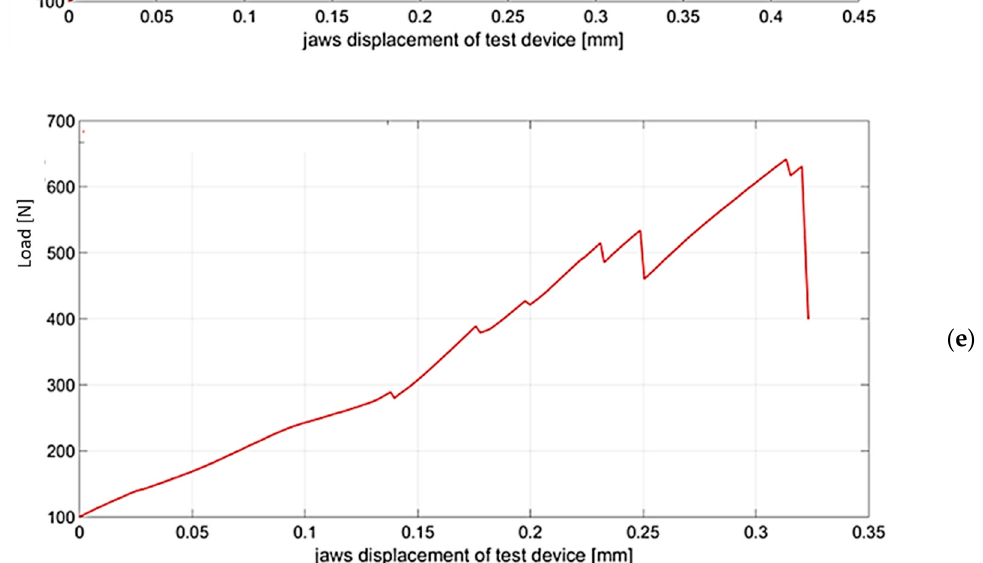
Figure 14. Measurement of critical force F cr : ( a ) e = 0; ( b ) e = 0.05; ( c ) e = 0.1; ( d ) e = 0.15; ( e ) e = 0.20 . Figure 15 shows the measured values of the critical force level and shows the resulting decreasing levels of critical force determined by linear regression. In Table 4 the processed measurement data are written.